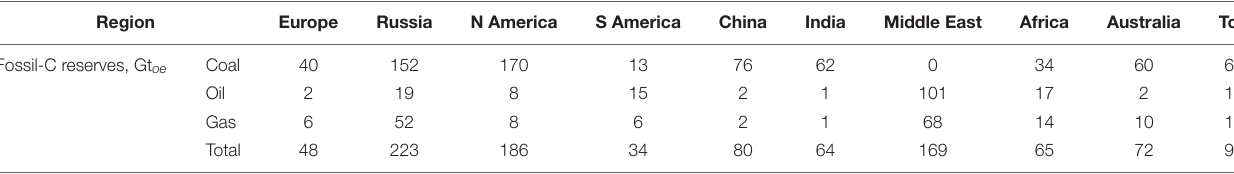
TABLE 1 | Estimated worldwide fossil-C availability (Gt oe , t oe = tons oil equivalent). Region